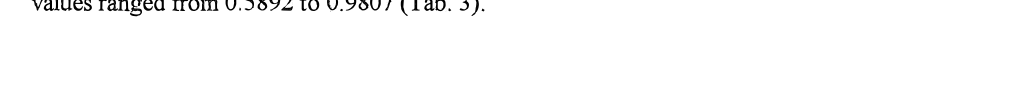
Spined loach has one row pharyngeal teeth (Fig. 2). In 31 % of the fish their pattern was 11 : 11, in 16.1% was 10:11, in 13.8% 9:10 and in 14.9% 10:10. Other fish were character­ ized by different patterns: 10:8, 8:10 and even 13:13. Upper part of arc is con­ cave, occuping low posi­ tion. Lateral part with a blunt processus. Upper end slightly forked, while the lower one bent